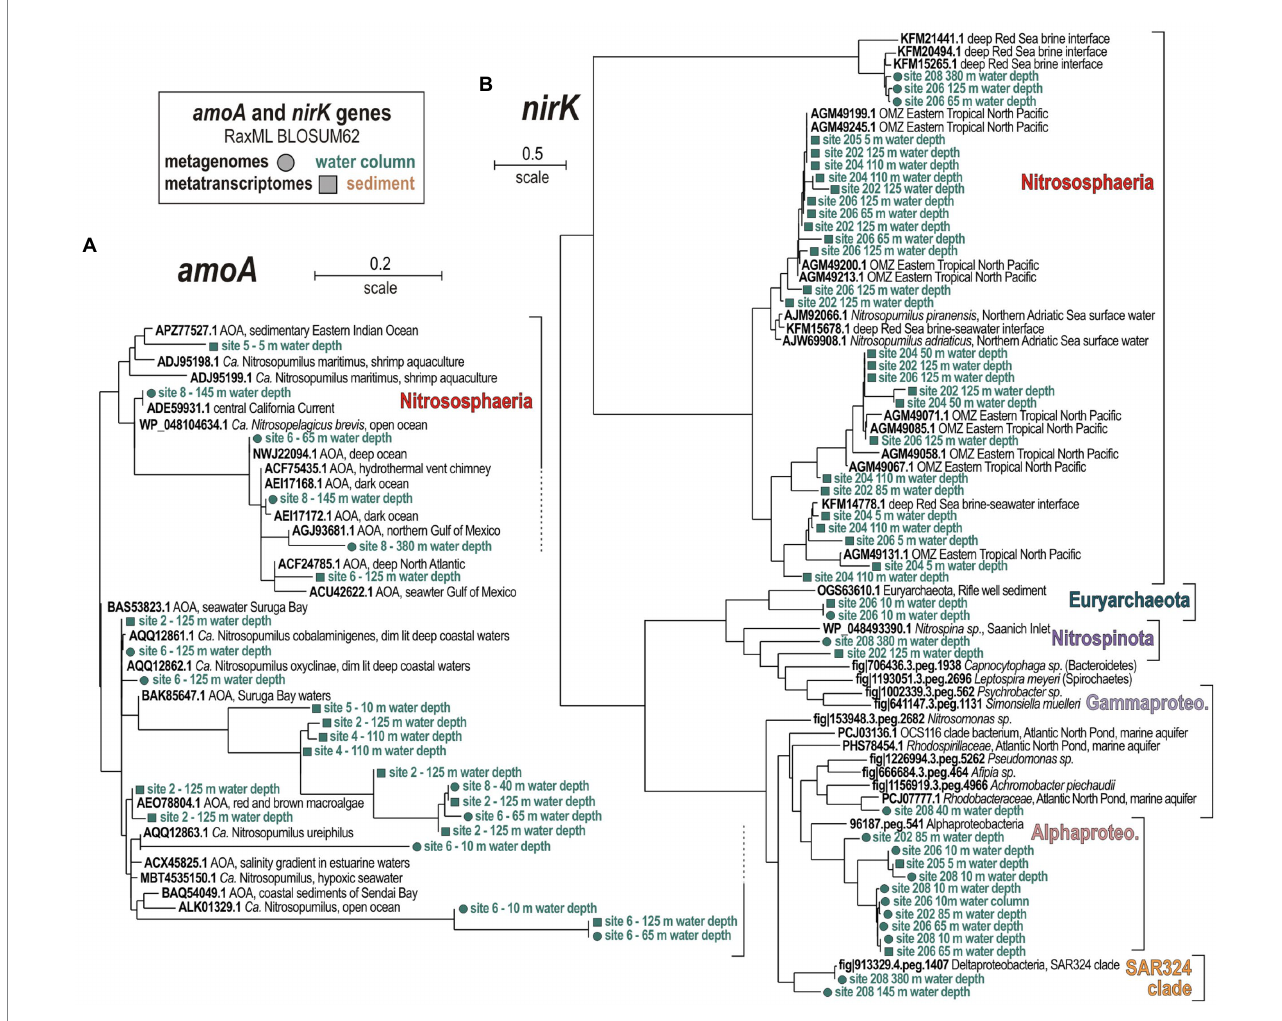
FIGURE 6 Phylogenetic analyses of predicted proteins encoded by (A) ammonia monooxygenase subunit A, and (B) nitrite reductase subunit K as the selected marker genes in the metagenomes and metatranscriptomes, based on RAxML using BLOSUM62 as the evolutionary model. (A) Phylogenetic tree of all amoA ORFs (185 aligned amino acid sites) detected in the metagenomes (circles) and metatranscriptomes (squares). (B) Phylogenetic tree of all nirK ORFs (133 aligned amino acid sites) detected in the metagenomes (circles) and metatranscriptomes (squares). Green and brown font, respectively, indicate water or sediment as the isolation source of the